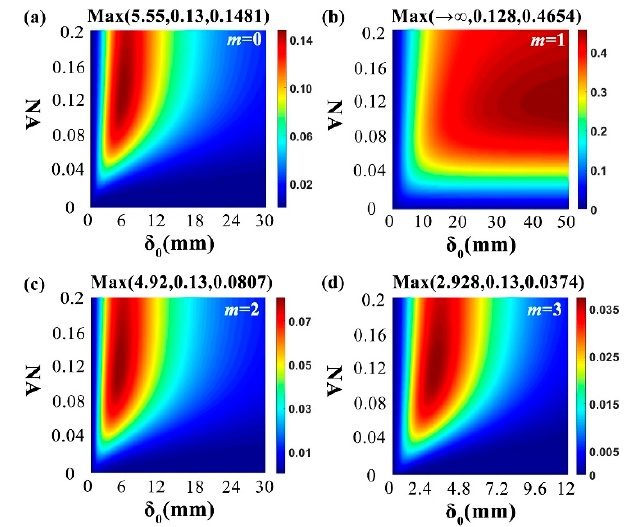
Figure 4. The density plot distribution of how the coupling efficiency of the symmetric beam with ω 0 = 10 mm and λ = 1550 nm varies with numerical aperture and initial spatial coherence under different topological charges.